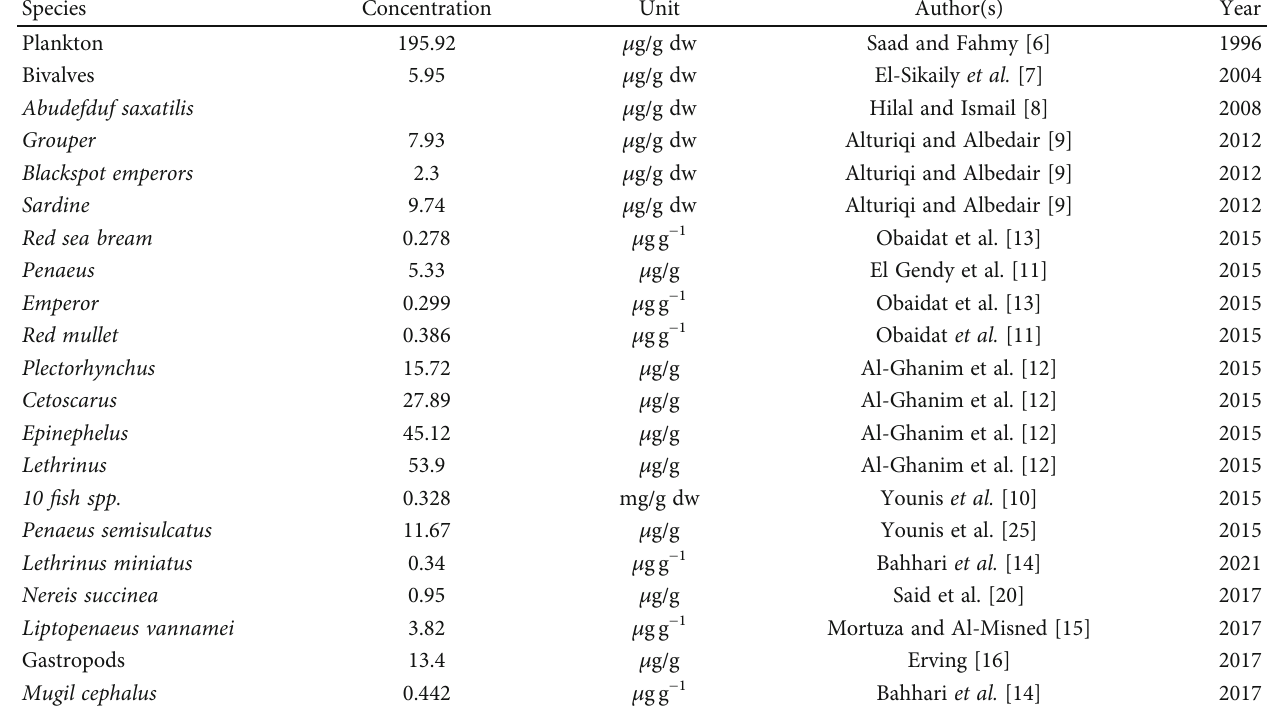
Table 2: Bioaccumulation of copper reported from the Red